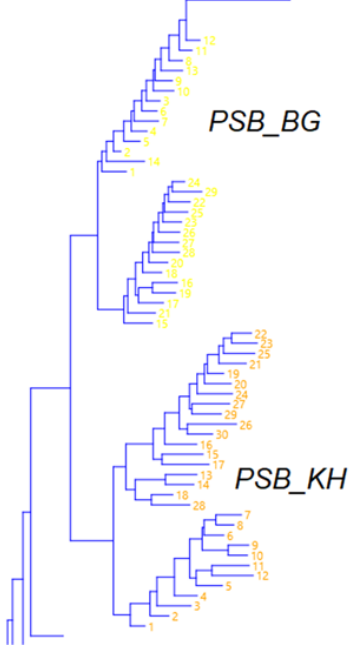
Figure 4. Dendrogram reflects the degree of similarity in ISSR profiles of the two studied samples of P. sibirica . The numbers are corresponded to the individual trees.